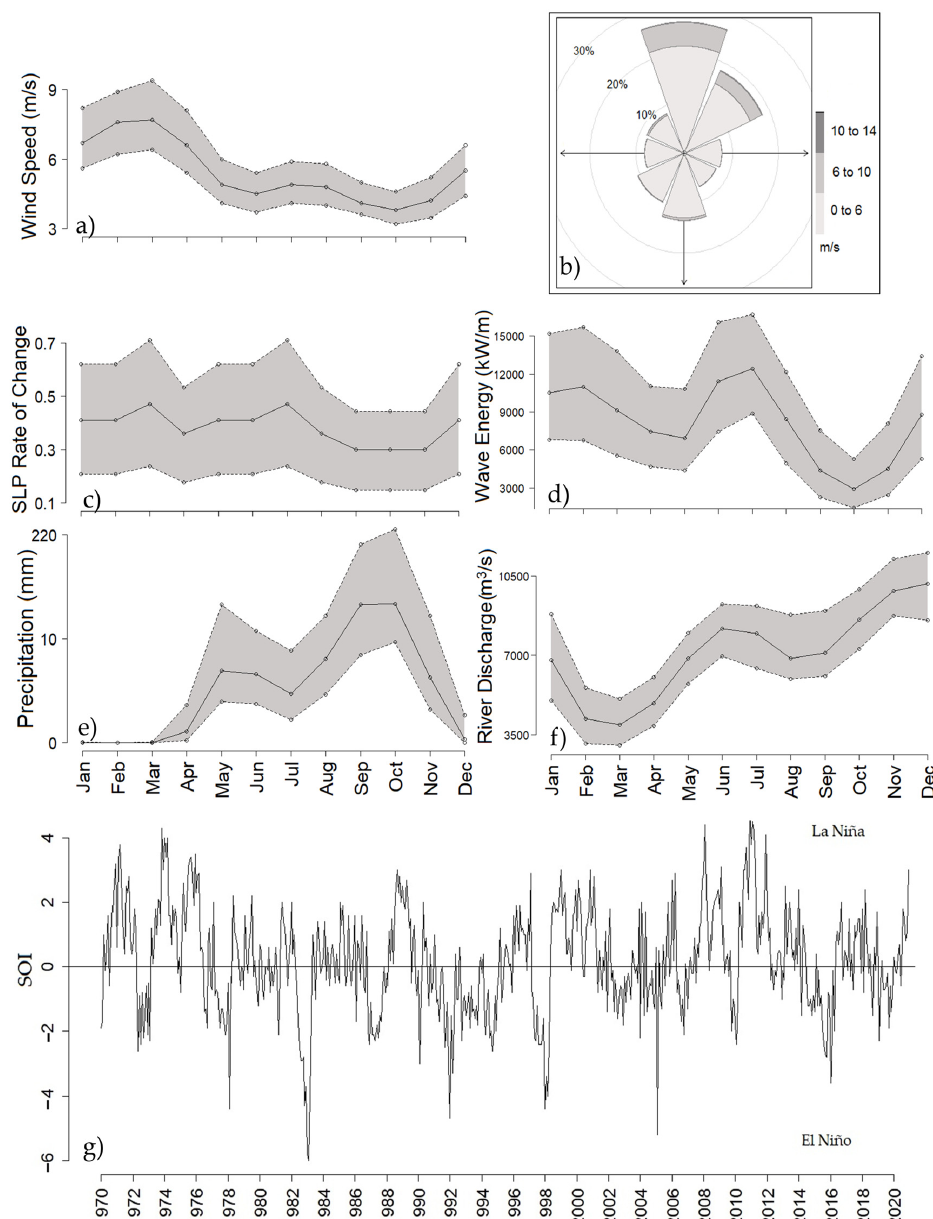
Figure 4. Monthly median, 25th and 75th percentiles of ( a ) wind speed, (Barranquilla), ( b ) wind direction (Barranquilla), ( c ) sea-level pressure, ( d ) wave energy (virtual buoy), ( e ) precipitation (Barranquilla), ( f ) Magdalena River discharge (Calamar) and ( g ) yearly ENSO oscillations based on the SOI index. Note: Monthly SLP rates of change were assessed for the A-A’ profile shown in Fig- ure 3.